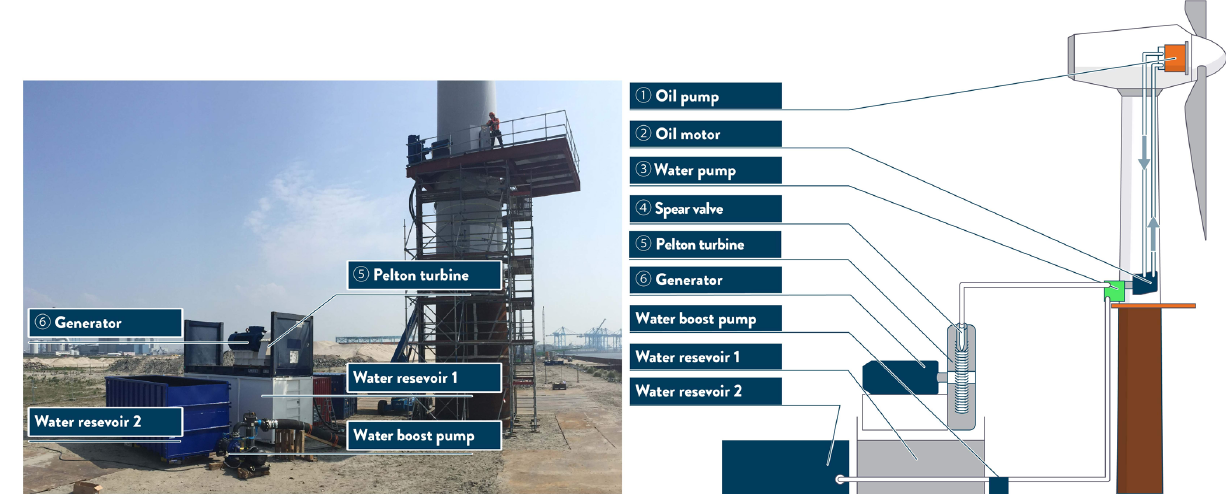
Figure 3. Overview of the intermediate DOT500 hydraulic wind turbine configuration. An oil pump is coupled to the rotor low-speed shaft in the nacelle and hydraulically drives an oil motor in the bottom of the tower. This closed oil circuit serves as a hydraulic gearbox between the rotor and water pump. The motor is mechanically coupled to a water pump, which produces a pressurized water flow. The flow is converted to high-velocity water jets by spear valves and a Pelton turbine–generator configuration harvests the hydraulic into electric